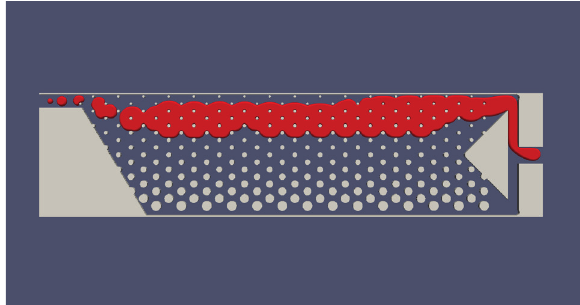
Fig. 6 – Simulation snapshot of the modified geometry. Inlet is on the left-hand side while outlet is on the right-hand side of the picture. The wetting phase is transparent, while the non-wet- ting phase is pictured red. Flow ratio wetting : non-wetting = 1:1; Re=0.27; Ca=0.024.